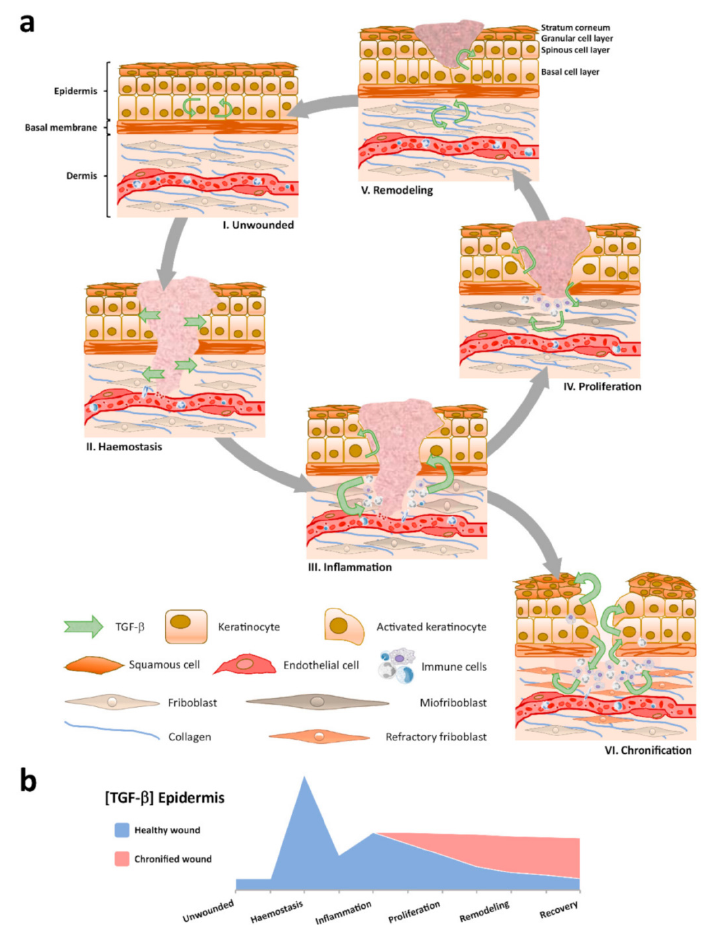
Figure 6. ( a ) Various TGF- β signatures; ( b ) the amount of TGF- β varies in the epidermis through the sequential stages of wound healing [89] .